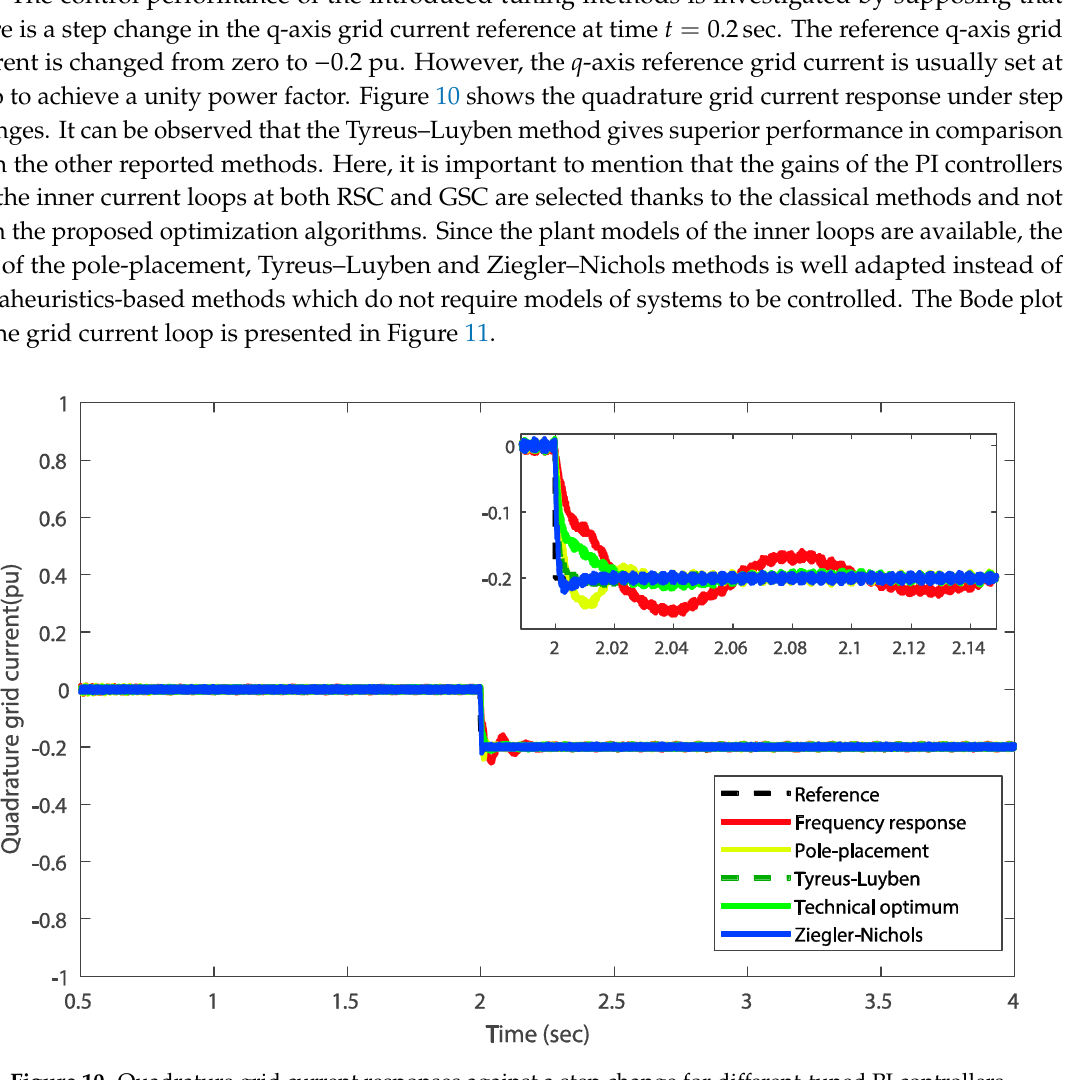
Figure 11. Bode plot of the open loop grid current loop: with and without passive damping based technical optimum tuning. The quality of the three phase grid currents is investigated through measuring the THD of the AC grid currents. As depicted in Figure 12. It is obviously shown that the use of the LCL-filter achieves a better attenuation with a THD value about 4.05% for which the IEEE519-1992 standard limits are respected. Further analysis can be made to compare the THD of the AC grid currents in the case of using an L-filter based structure. According to the results of Figure 12, it is clear that the THD for adopting the LCL-filer is smaller than that using the L-filer type at the same value of inductance.